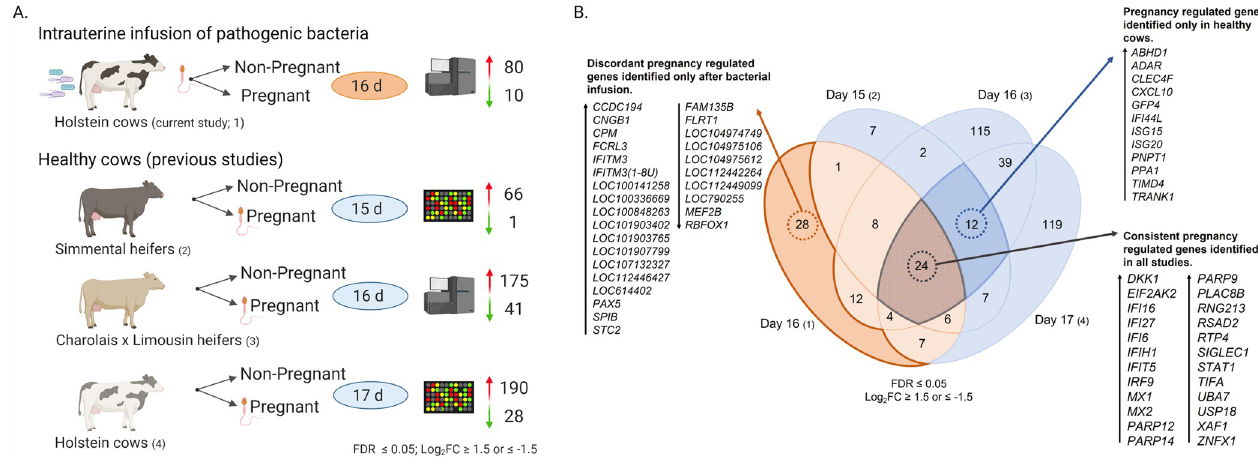
Fig 3. Consistent and discordant pregnancy regulated genes in the endometrium of healthy cows and cows following intrauterine infusion of pathogenic bacteria. Data from previously published studies using healthy cows were compared to the current data from cows after intrauterine infusion of bacteria. (A) Differentially expressed genes with an FDR � 0.05 and log 2 FC � 1.5 or � -1.5 from all studies were considered. Holstein cows were inseminated 130 days after intrauterine infection of pathogenic bacteria and sixteen days later classified as non-pregnant or pregnant based on the presence of a conceptus and IFNT (orange). Three previous studies were used for comparison (blue), including 1) microarray analysis of Simmental heifers either inseminated with sperm-free supernatant and classified as non-pregnant cycling or inseminated and classified as pregnant based on presence of a conceptus fifteen days later [17]; 2) RNA sequencing of crossbred Charolais and Limousin heifers either never inseminated and classified as non-pregnant cycling, or inseminated and classified as pregnant based on presence of a conceptus sixteen days later [19]; and 3) microarray analysis of Holstein cows either not inseminated and classified as non- pregnant cycling, or inseminated and classified as pregnant based on the presence of a conceptus seventeen days later [18]. Comparisons show differentially expressed genes in the pregnant cows compared to the non-pregnant cows. (B) A Venn diagram displays the overlap of differentially expressed endometrial genes in all four studies. The orange segment represents the current study in cows after infusion of bacteria, and the blue segments represent previous studies using healthy cows. Arrows depict if genes were upregulated or downregulated in the endometrium of pregnant cows compared to non-pregnant cows. A complete list of differentially expressed genes from all studies used here can be found in S2–S4 and S12 Tables , and a list with details of genes listed in the figure can be found in S13 Table .